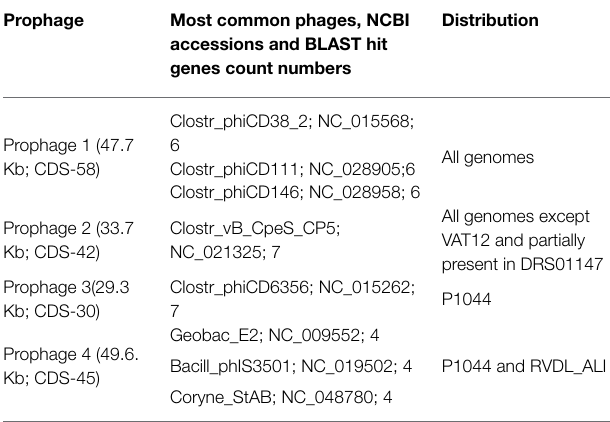
TABLE 3 | Predicted prophages and their distribution across C. septicum